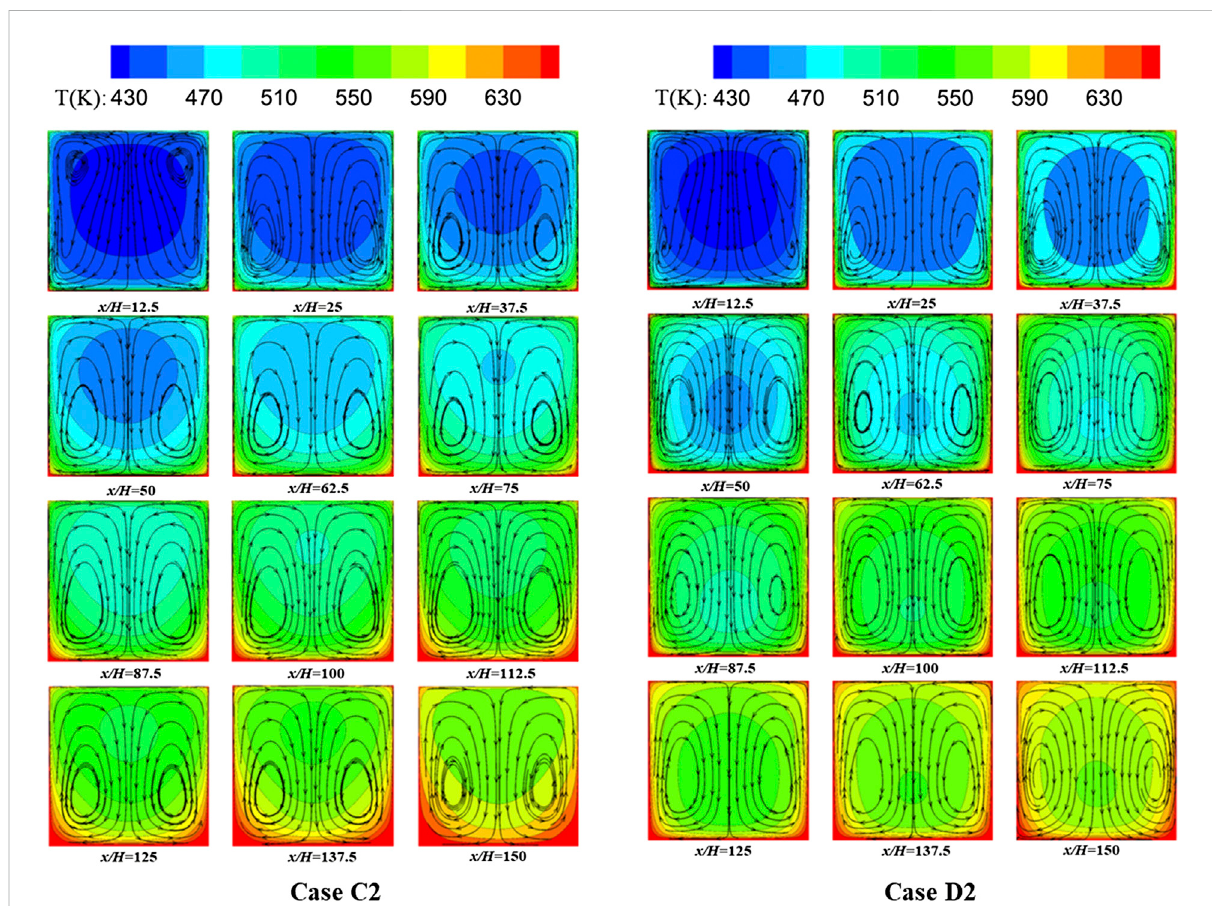
FIGURE 9 Streamlines and temperature contours on y-z sections for the cases, respectively, loaded with the increased and decreased heat fl ux distributions (Case C2 and Case